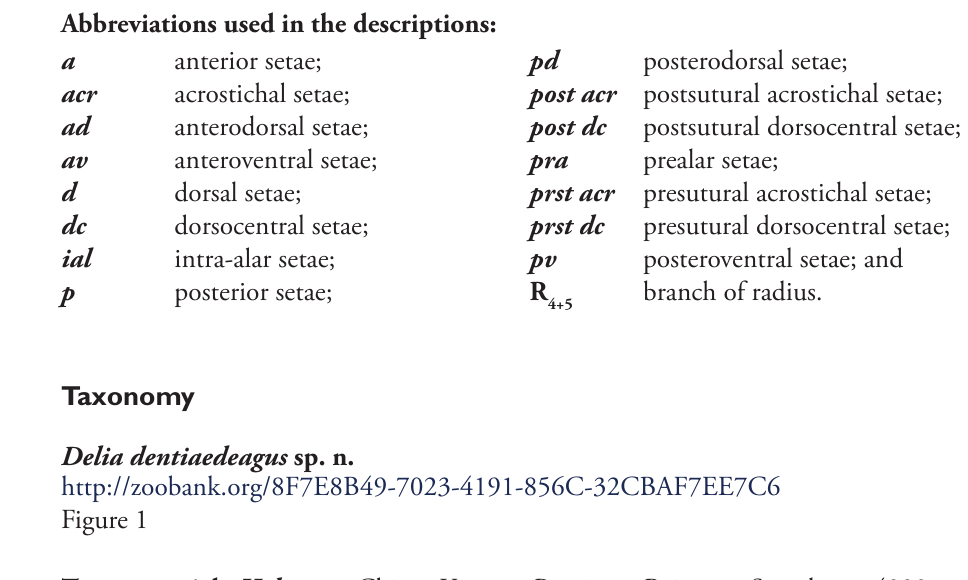
Type material. Holotype . China, Yunnan Province, Baimang Snowberg, 4000 m, 29 May 2007, Dandan Wang Co., ♂ (IESNU). Paratype . China, Yunnan Province, Baimang Snowberg, 4000 m, 31 May 2007, Lu Zhang Co., 2 ♂♂ (IESNU). Diagnosis. Arista short ciliated, longest hairs shorter than its basal diameter; legs black; mid tarsomere 1 with long ad ; processes of 5th sternite slender, with long and dense setae, without spine or protrusion. Description. Holotype Male. Body length 4.5–5.0 mm. Head . Eye bare; frontal vitta dark brown without interfrontal setule; fronto-orbital plate adjacent; frons as wide as anterior ocellus; without orbital setae;